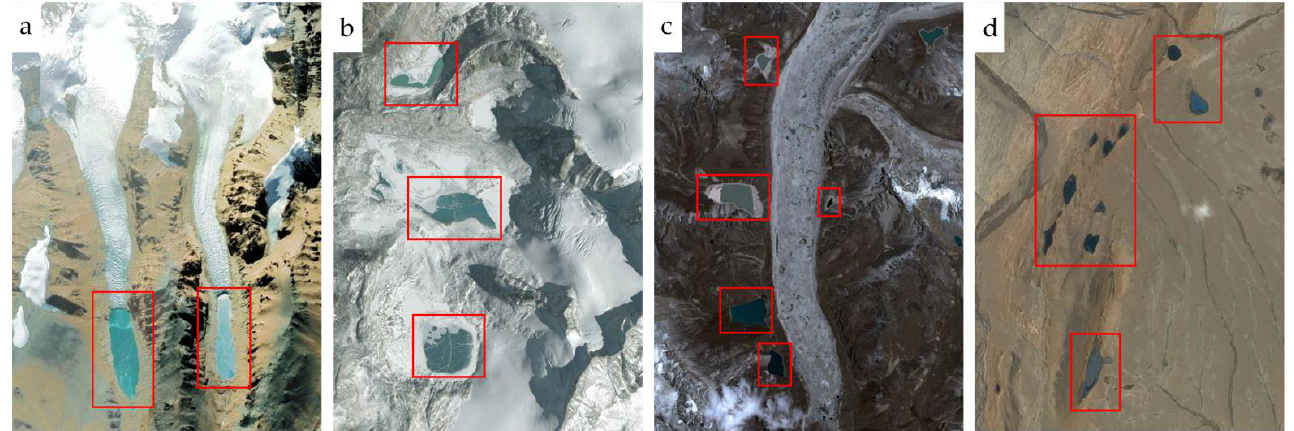
Figure 3. Example pictures of each type of glacial lake (in red rectangle) in the TP: ( a ) proglacial lakes; ( b ) supraglacial lakes; ( c ) ice-marginal lakes; ( d ) unconnected glacial lakes. Background imageries were obtained from © Google Earth Pro.